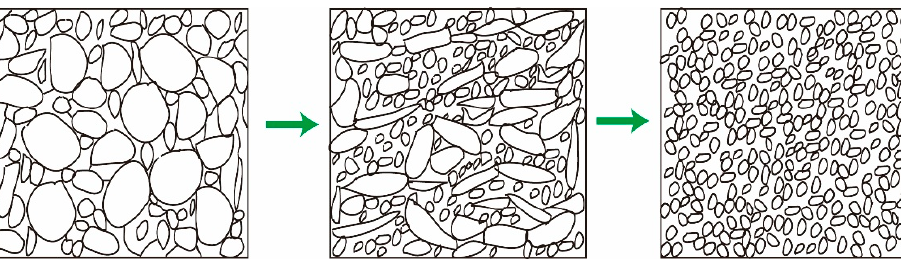
Figure 14. Schematic diagram of recrystallization of TC4 alloy during MDIF